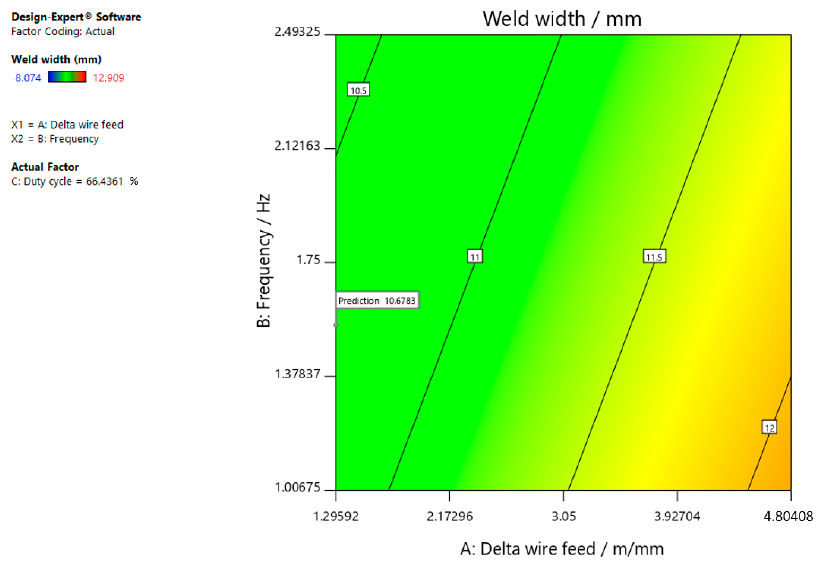
Figure 14. Optimal parameters for achieving the weld width with a target value of